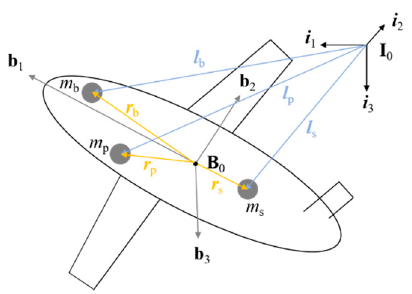
Figure 2. Mass distribution of Petrel-II underwater glider.